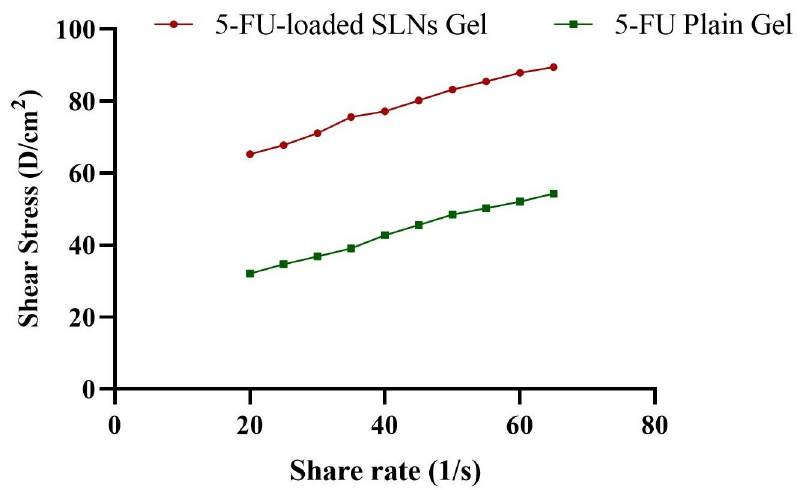
Fig 11. Rheograms of 5-FU plain gel and 5-FU-loaded SLNs gel.